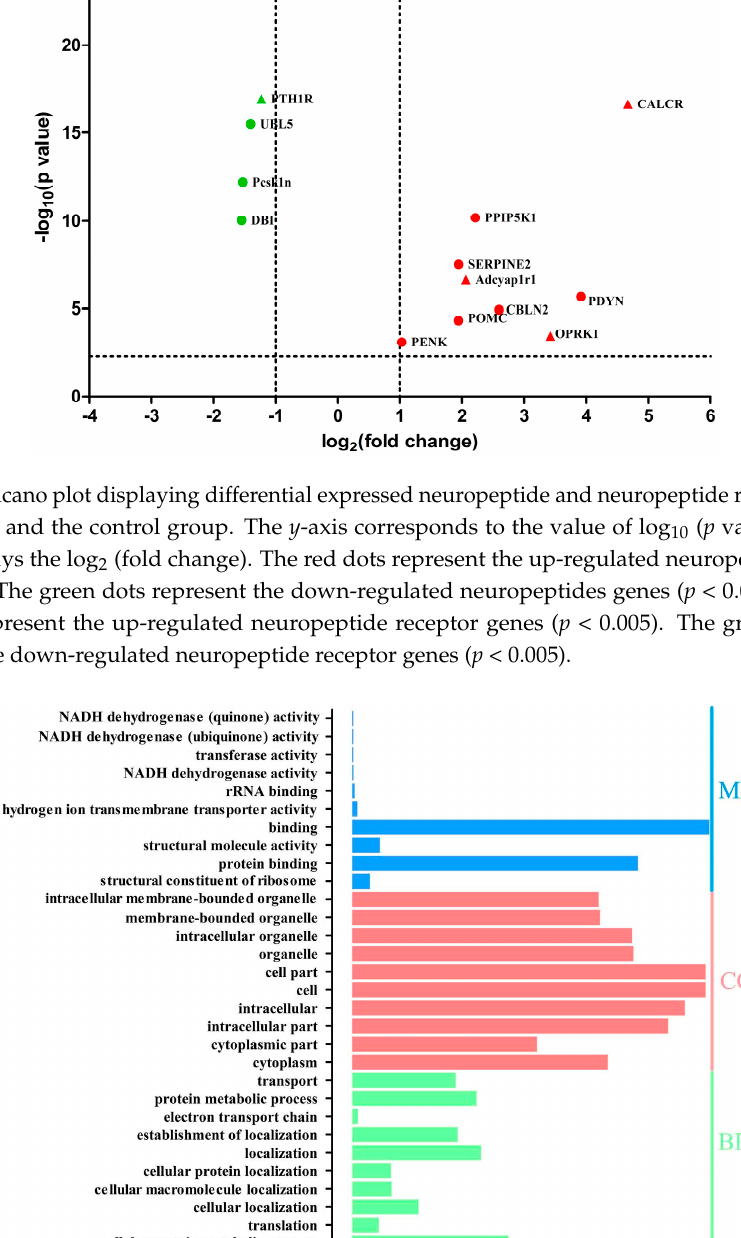
Figure 4. The most enriched gene ontology (GO) terms of differentially expressed genes between EA and the control group. Three aspects of Go terms are biological process (BP), cellular component (CC) and molecular function (MF).